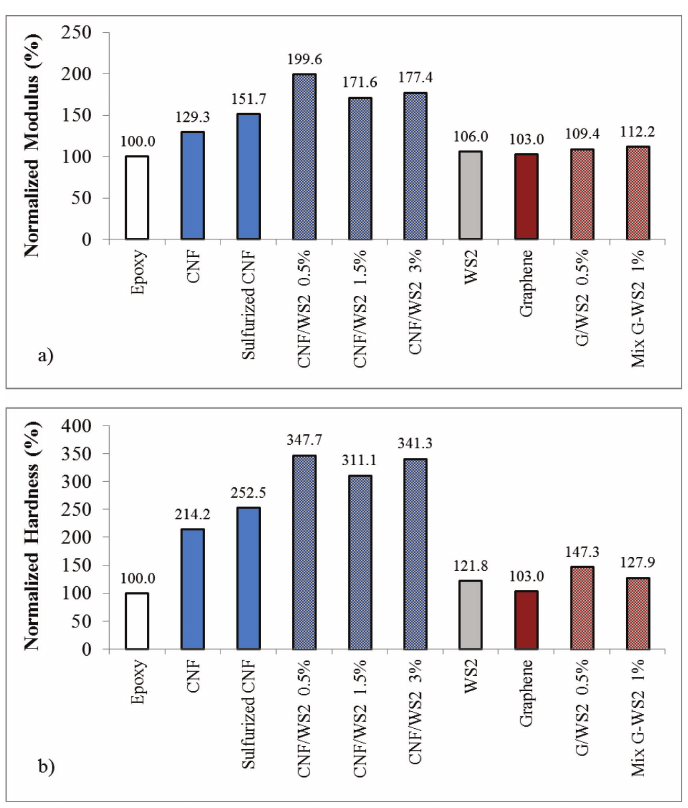
, CNT/IF-WS hybrids or Graphene/IF-WS 2 2